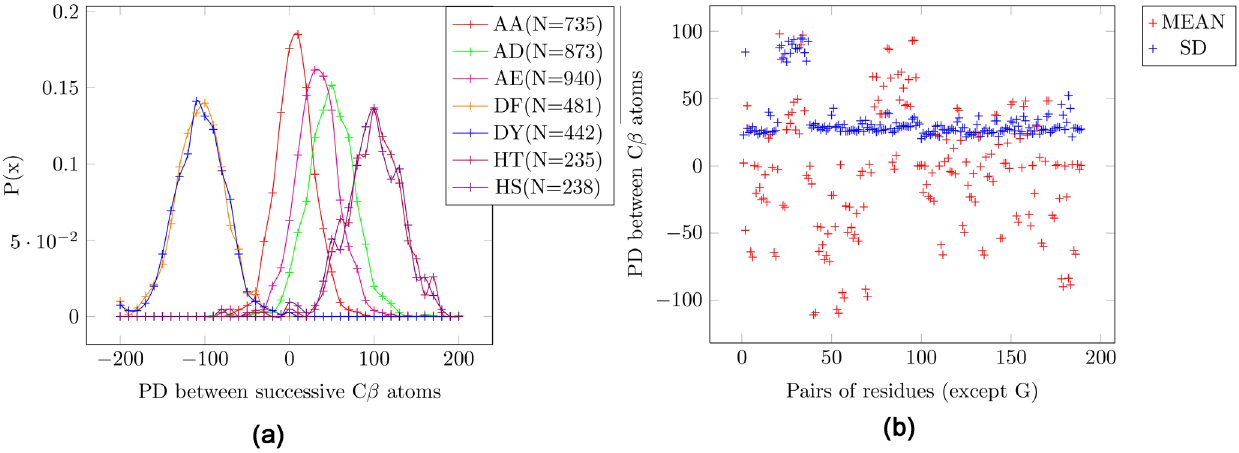
Figure 3. Electrostatic potential differences (PD) for consecutive residue pairs for C β atoms. AA: Alanine/Alanine, AD: Alanine/Aspartic- acid, AE: Alanine/Glutamic-acid, DF: Aspartic-acid/Phenylalanine, DY - Aspartic-acid/Tyrosine, HT: Histidine/Threonine, HS: Histidine/Serine. ( a ) Probability distribution for seven pairs of amino acids. ( b ) Scatter plot for all pairs of amino acids. The pairs which include cysteine have a high standard deviation. It is seen that the mean is much more varied than the electrostatic potential difference (EPD) for C α and the C-N peptide bond.